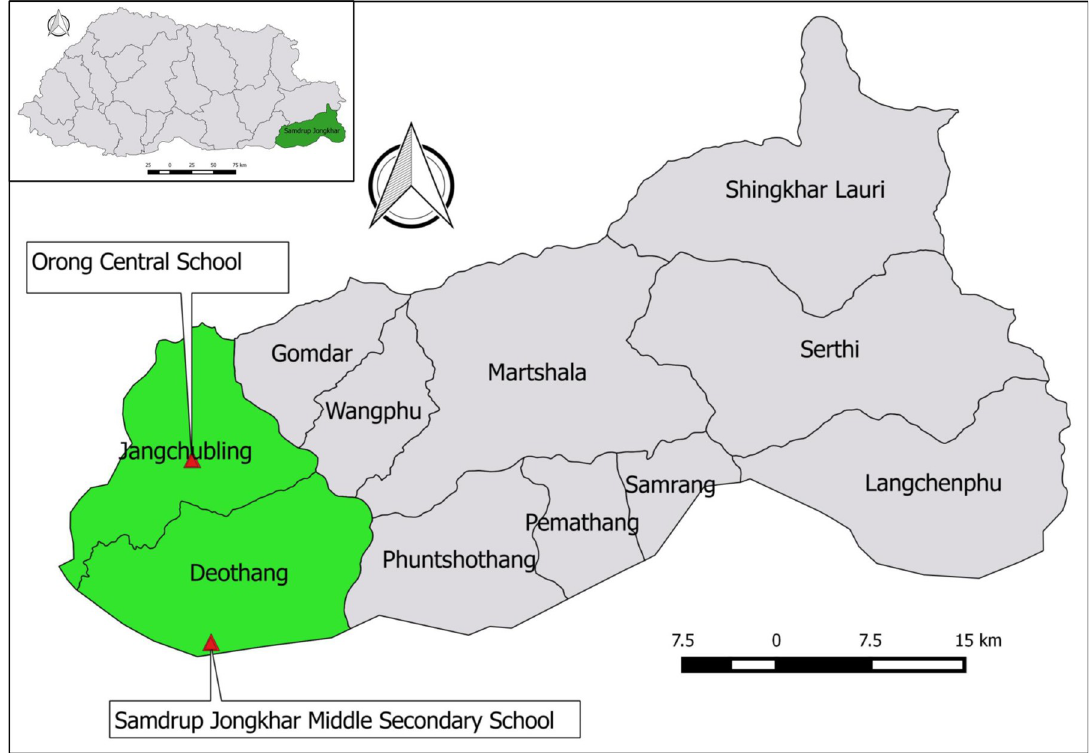
Fig 1. Map of Bhutan showing the location of two study schools—Orong Central School Samdrup Jongkhar Middle Secondary School) The maps were generated using QGIS software (QGIS Development Team, 2019).